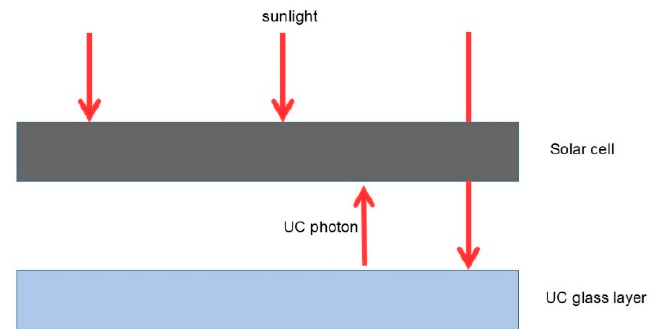
Figure 1. Schematic for up-conversion using glass layers in solar cell applications.